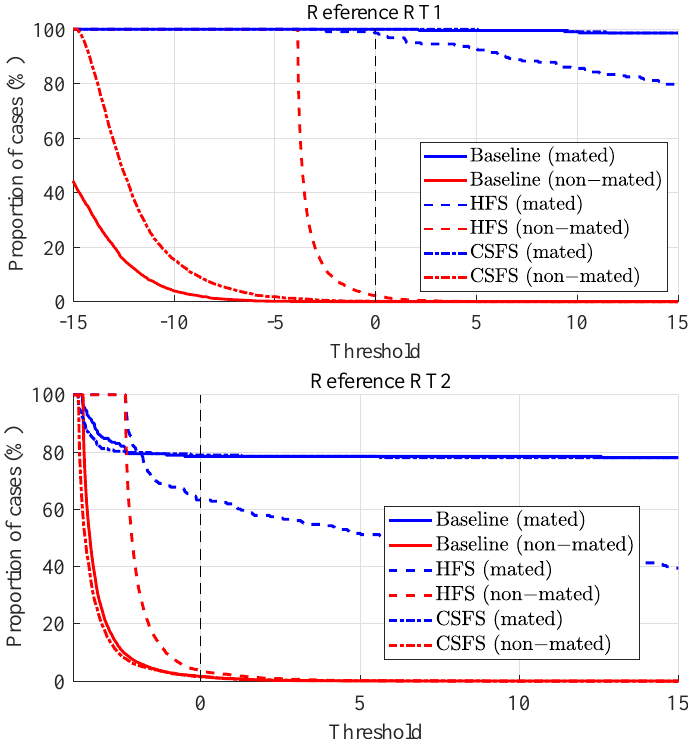
Figure 10. Tippett plots: non-stabilized videos vs. RT1 (upper) and RT2